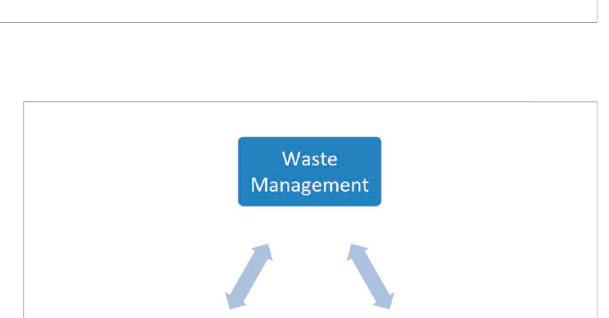
FIGURE 1 Geographic location of the study area in the Mediterranean region of southern Turkiye.